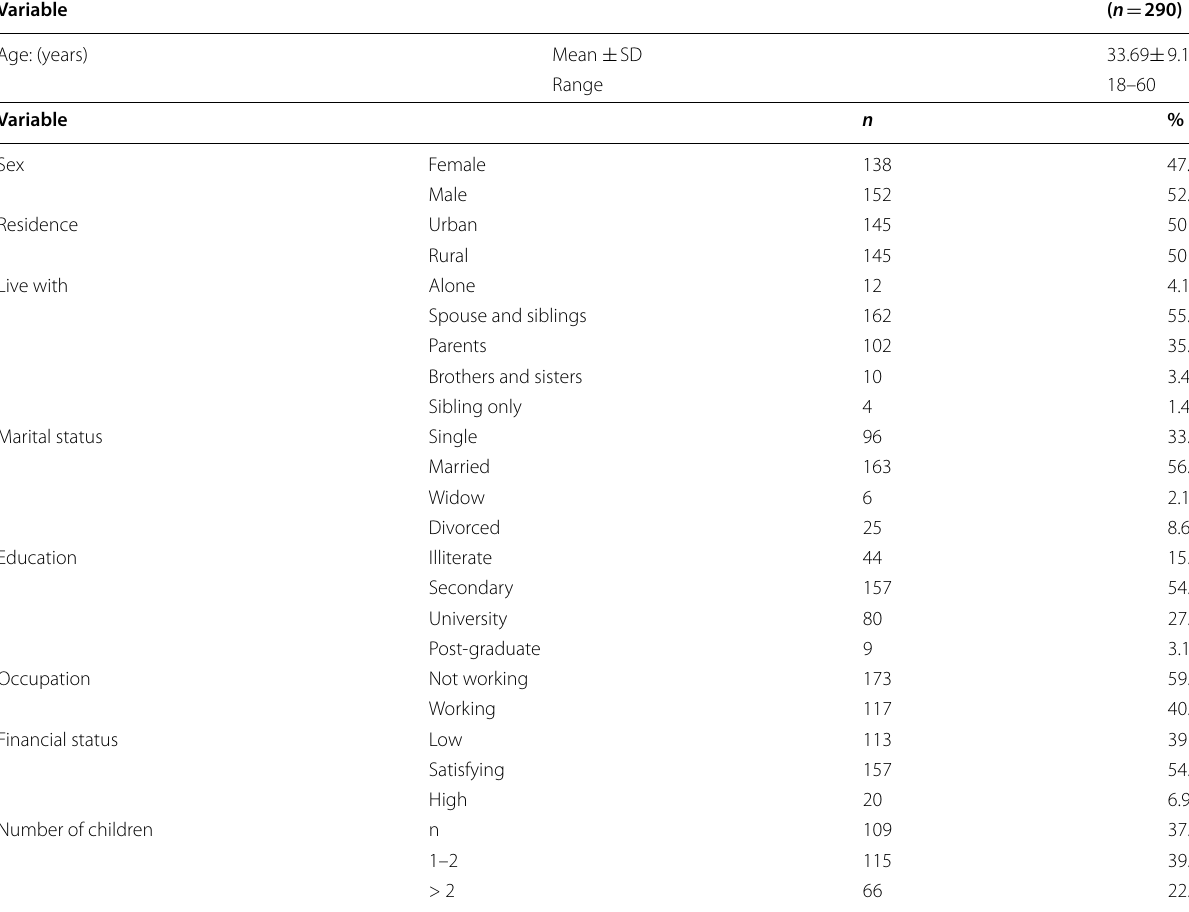
Table 1 Demographic characteristics of the studied